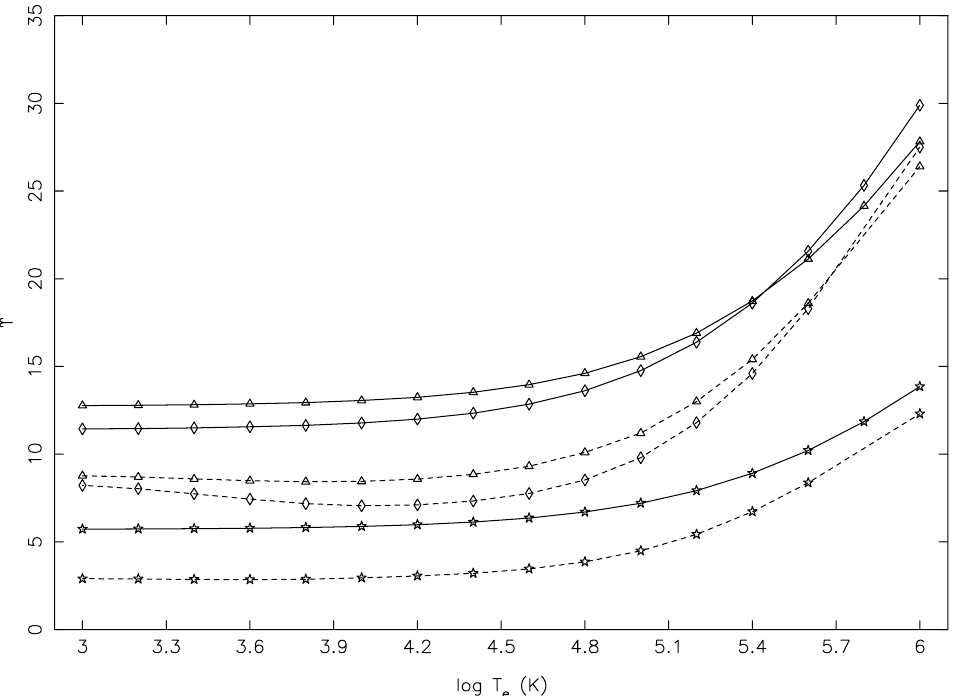
Figure 4. Comparison of FAC and BSR values of Υ for the 4–29 (triangles: 3p 2 1 D 2 –3s3p 3 ( 2 D) 1 D o 4–30 (diamonds: 3p 2 1 D 2 –3p3d 1 F o